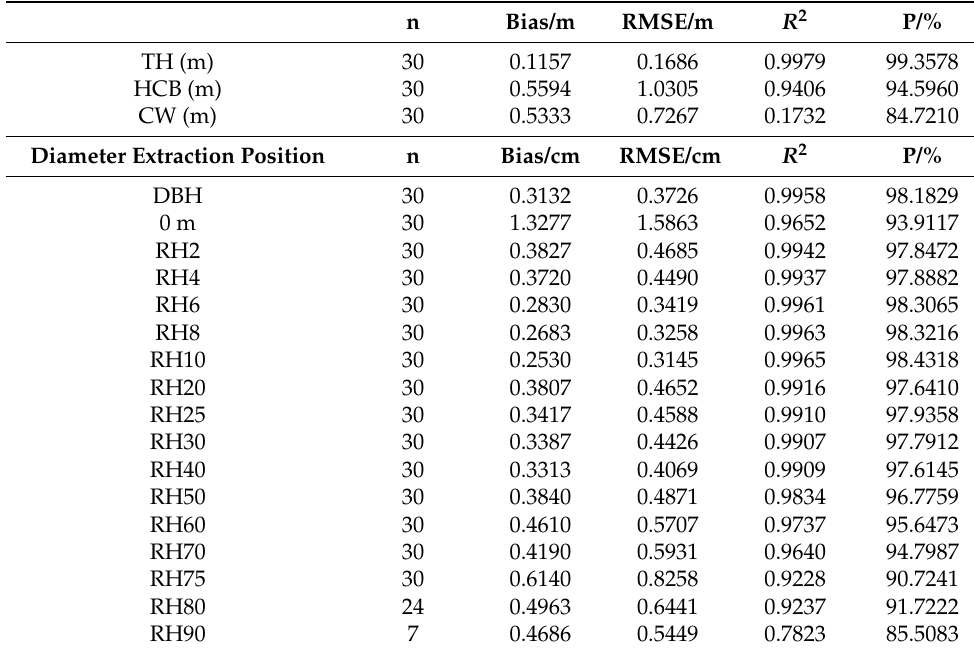
Table 3. Summary of the point cloud-extracted